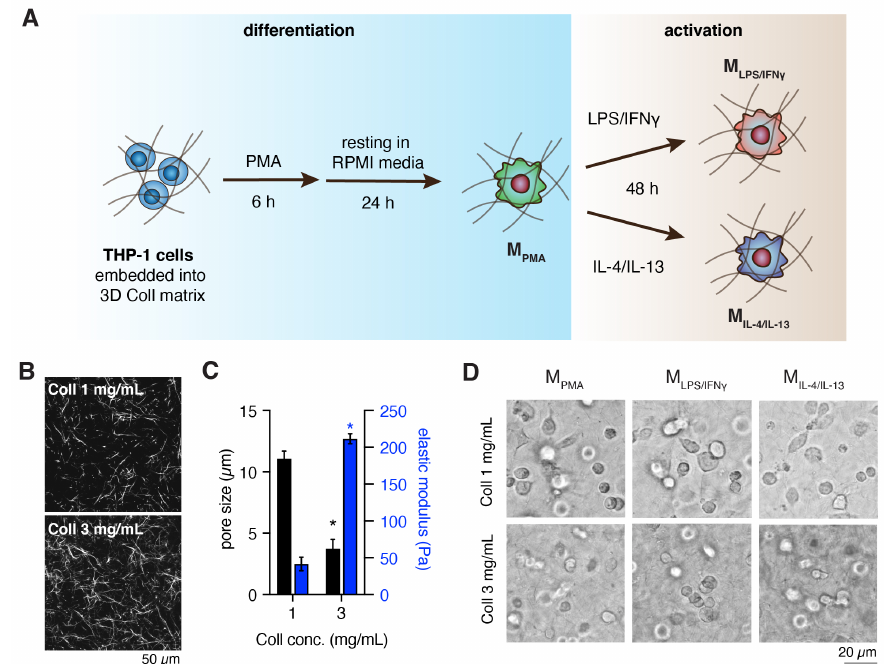
Figure 1. Differentiation and activation of macrophages, matrix characterization and morphology of THP-1 derived macrophages. ( A ) Schematic illustration of macrophage differentiation and activation in 3D collagen matrix. ( B ) Representative images of collagen matrices visualized using confocal laser scanning microscopy (cLSM, scale bar = 50 µm). ( C ) Topological and mechanical characterization of 1 mg/mL and 3 mg/mL collagen matrices. Topological analysis was quantified at 3 random positions of each matrix. All experiments were performed in triplicates. (Data are represented as mean ± standard deviation (SD); * significance level of p < 0.05). ( D ) Representative cell morphology of THP-1 derived macrophages in 1 mg/mL and 3 mg/mL of 3D collagen matrices (scale bar = 20 µm).